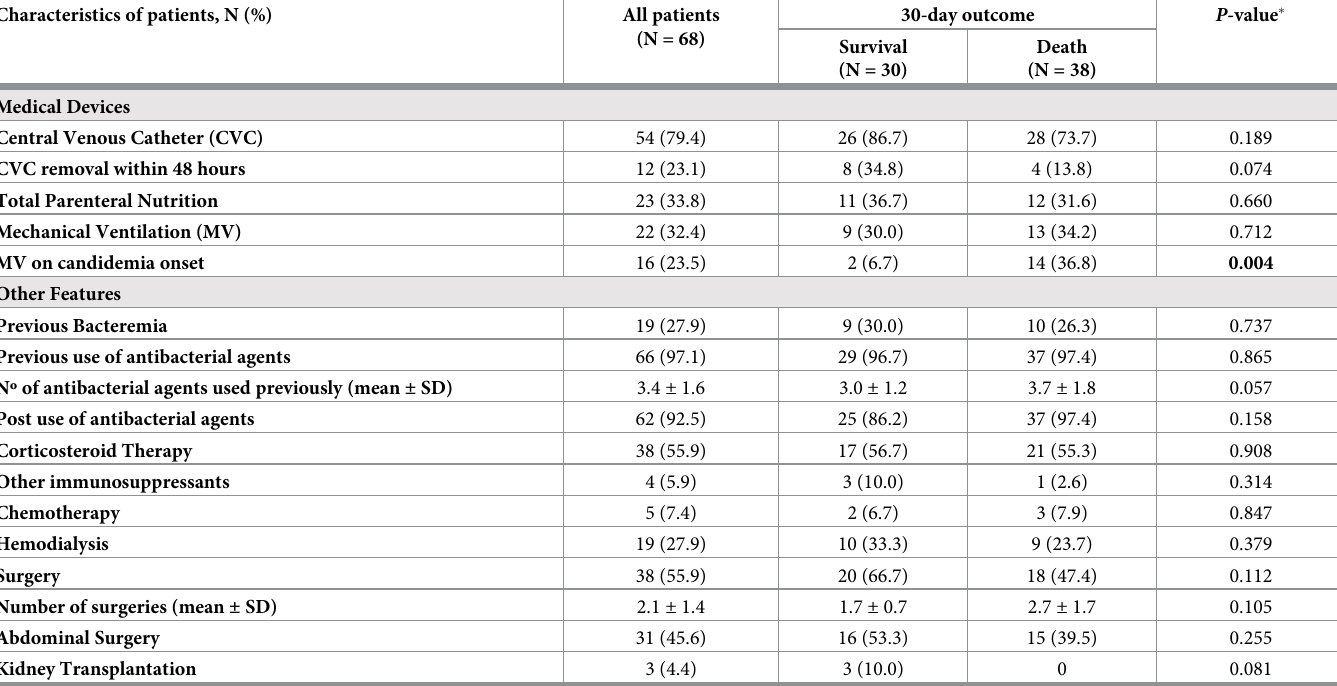
Table 3. Predisposing factors for Candida bloodstream infection and other characteristics of patients with candidemia, including comparison between subgroups according to the outcome. Characteristics of patients, N